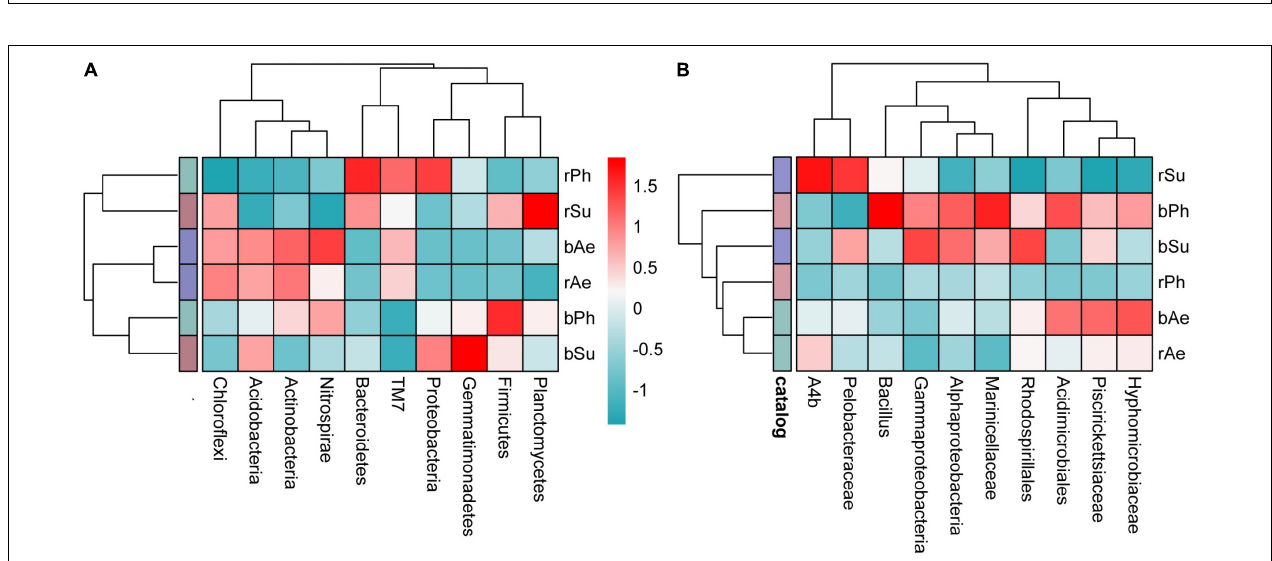
Frontiers in Ecology and Evolution |